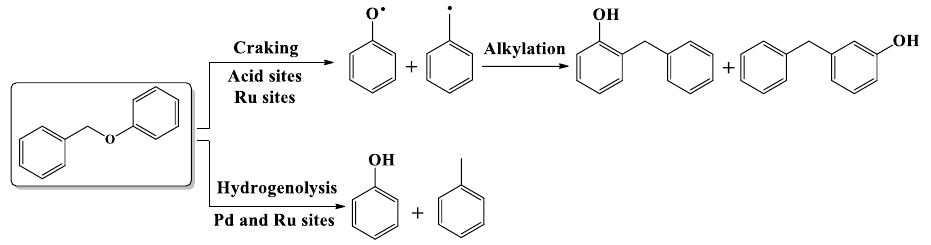
Scheme 1. Reaction route for BPE conversion over Pd- and Ru-based catalysts.